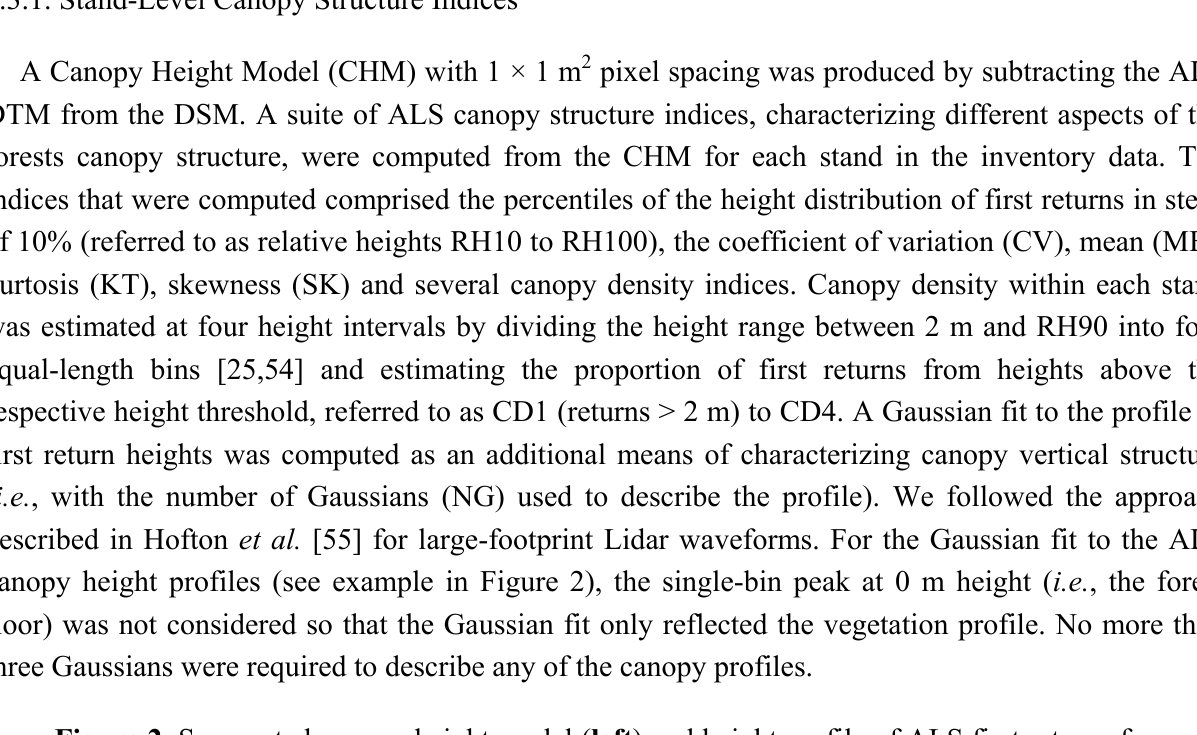
Figure 2. Segmented canopy height model ( left ) and height profile of ALS first returns for a radiata pine stand with a GSV of 96 m 3 /ha and a CH of 17 m ( right